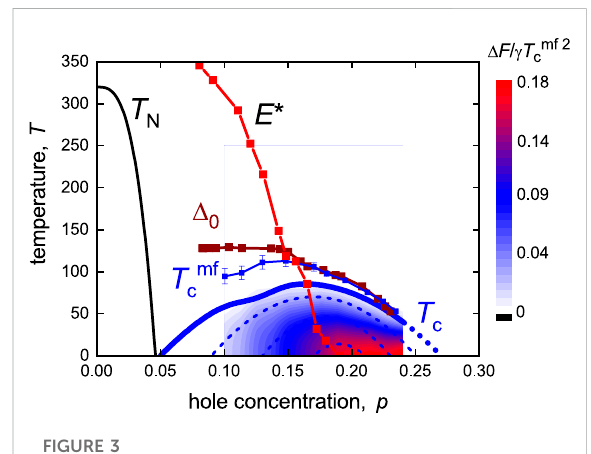
FIGURE 3 Summary of extracted data for Y 0.8 Ca 0.2 Ba 2 Cu 3 O 7 − δ . The T p ) phase curve; the ground-state superconducting energy gap, c ( Δ p ); and pseudogap energy, E *( p ), all expressed in temperature 0 ( units. The mean- fi eld T c , T mf c ( p ) obtained from the entropy-